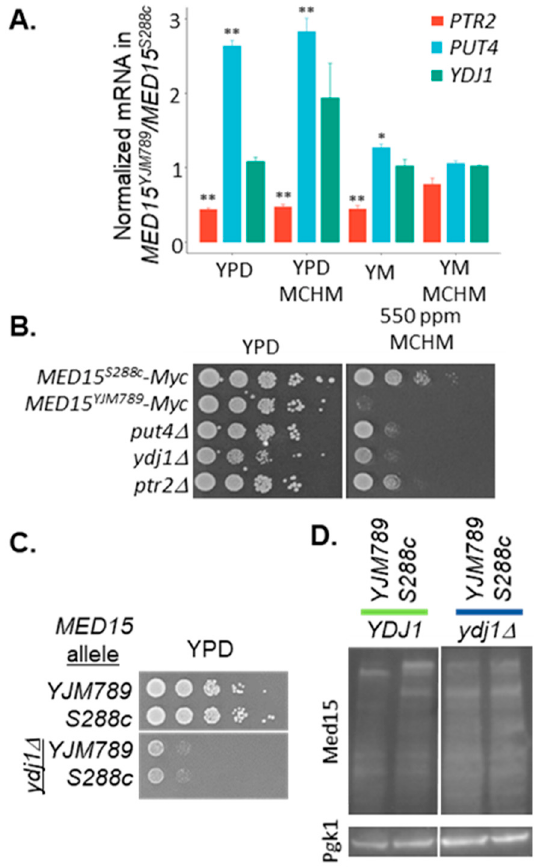
Figure 5. Conditions that a ff ected the stability of Med15. ( A ) Expression levels of PTR2 , PUT4 , and YDJ1 extracted from RNAseq data from Supplemental Table S1. ( B ) Plasmids containing Med15 YJM789 -Myc and Med15 S288c -Myc were transformed into single mutants of med15. The put4 , ptr2 , and ydj1 in the BY4741 background were grown and serial dilutions of yeast on YPD were grown for 2 days at 30 ◦ C and then photographed. ( C ) Serial dilution of yeast knockouts of ydj1 yeast expressing YJM789 or S288c alleles of Med15-Myc on YPD. ( D ) Western blot of YJM789 or S288c alleles of Med15-Myc immunoprecipitated from BY4741 or the ydj1 mutant, which were grown in YPD.